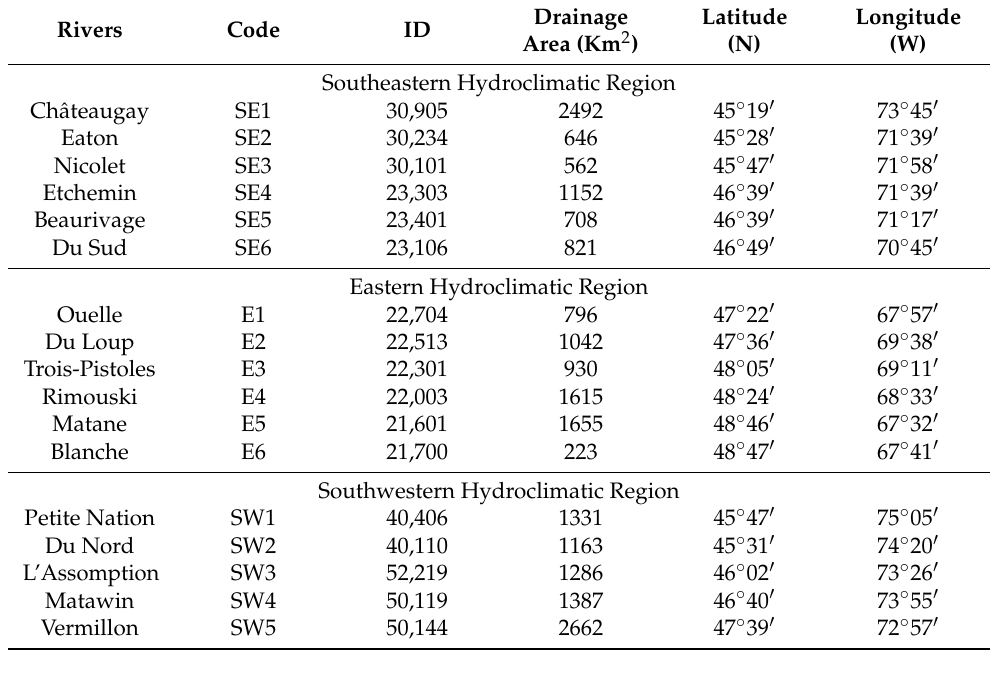
Table 1. Description of the stations studied.